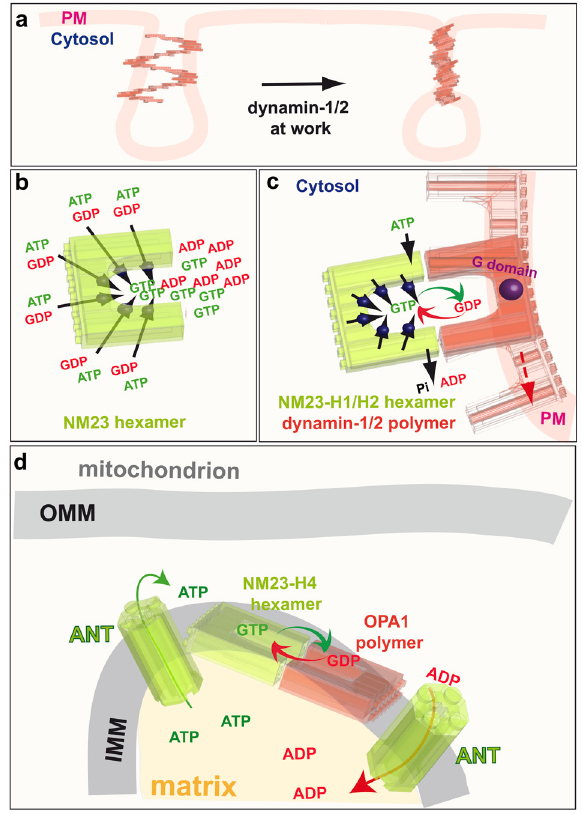
Figure 6. GTP channeling, the dynamins and the NM23/NDPK connection. a : Classical endocytic dynamins (dynamin-1 and dynamin-2) are recruited to clathrin-coated pits where they catalyse plasma membrane fission by creating torque. b : NM23, an NDPK that produces GTP from GDP and ATP, is a hexamer with six active sites. c: The NDPKs NM23-H1 and NM23-H2 (green) are recruited to clathrin-coated pits by their physical interaction with dynamin-1 and dynamin-2 (red). The NDPKs thus regenerate local GTP from GDP and intracellular ATP by a channeling mechanism to optimise dynamin activity. d: NM23-H4 activity in the